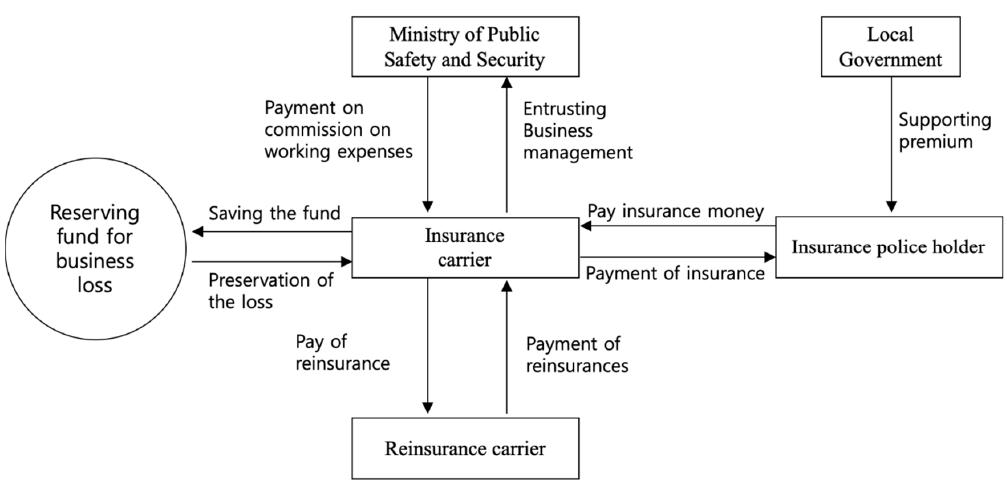
Figure 2. Flood and storm insurance business operation system.